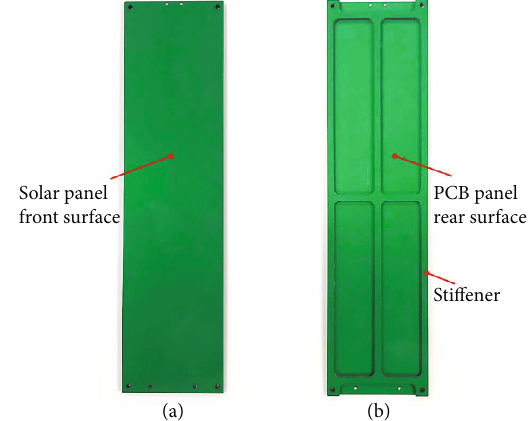
Figure 2: Demonstration model of the 3U solar panel: (a) front view and (b) rear